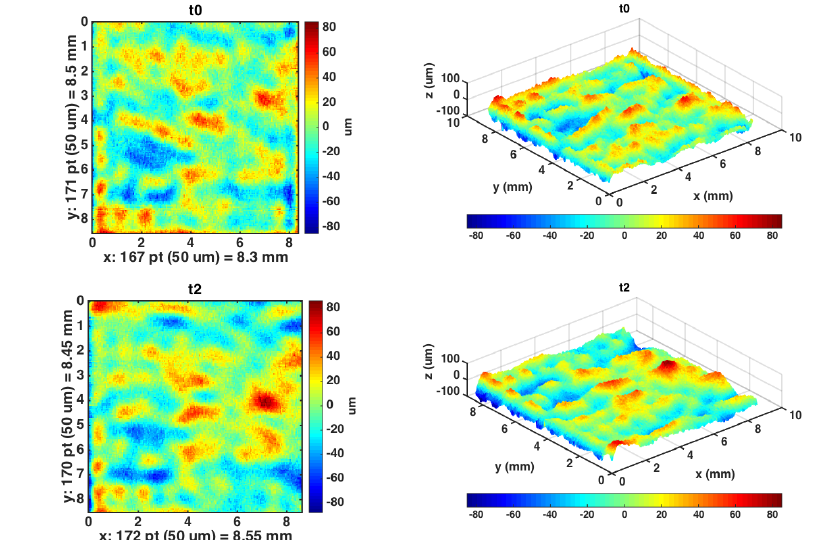
Figure 3. Surface data plotted as 2D height map of T0 and T2 and its 3D